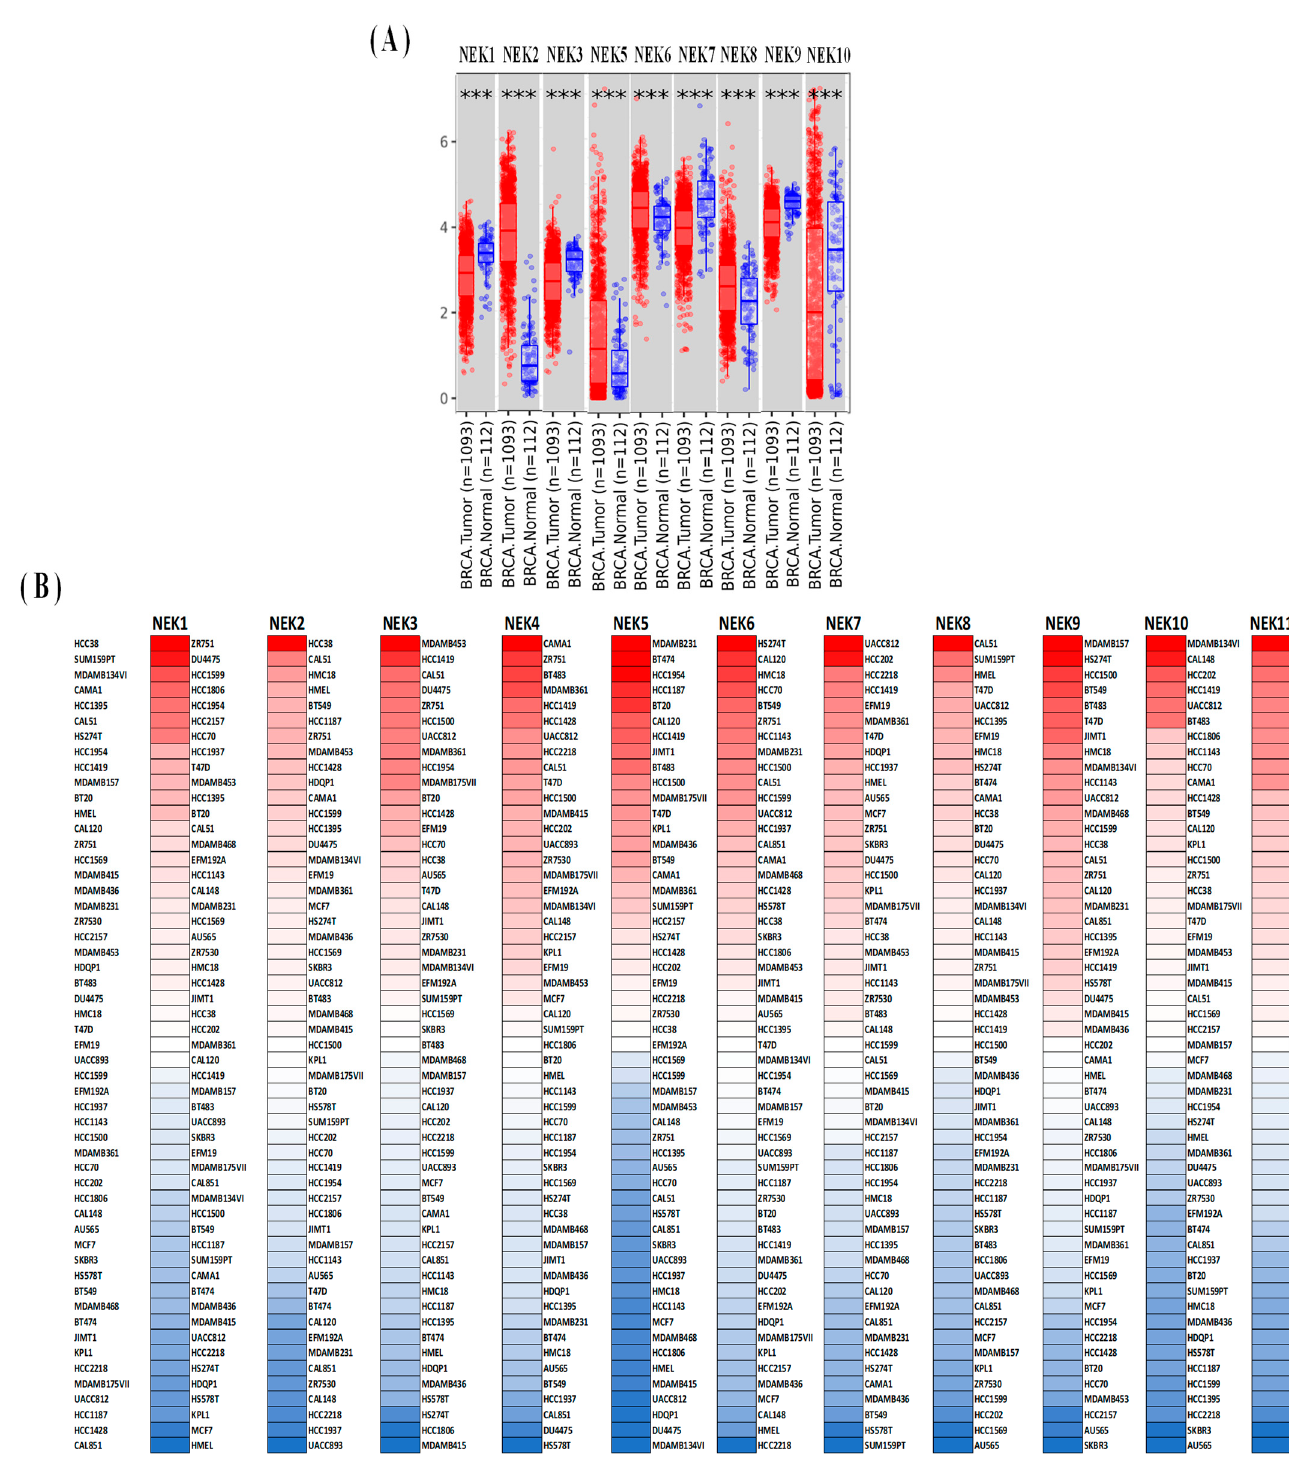
Figure 2. Expression of the NEK gene family in breast cancer. ( A ) Box plot of the NEK gene family’s transcripts in normal and breast cancer tissues in the TIMER database. Statistical significance was calculated using the Wilcoxon test, *** p < 0.001. ( B ) Heatmap of the NEK gene family’s expression levels in breast cancer cell lines (CCLE). We used mRNA expression values from the CCLE database, and then displayed them by their ranking. In CCLE, red represents overexpression (top column) and blue indicates under-expression (bottom column).